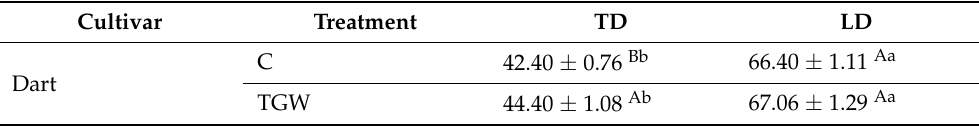
Table 8. Changes of transversal diameter (TD) and longitudinal diameter (DL) of two tomato cultivars irrigated with ground water (C) and treated grey water